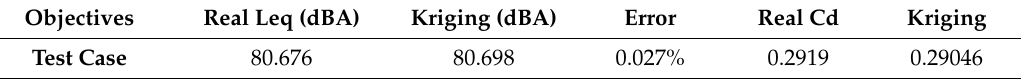
Table 4. The comparison between the CFD calculations and prediction from the Kriging model.